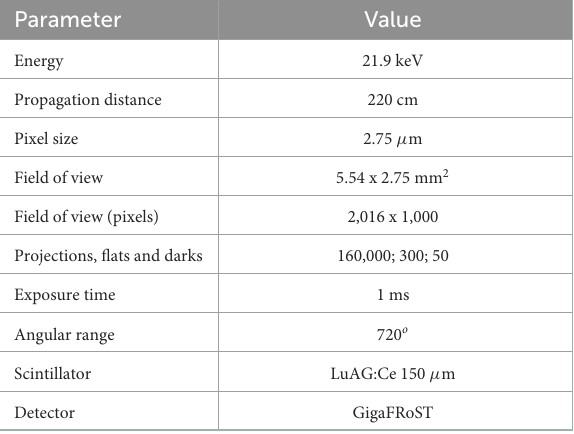
TABLE 2 Experimental dynamic acquisition parameters at the TOMCAT